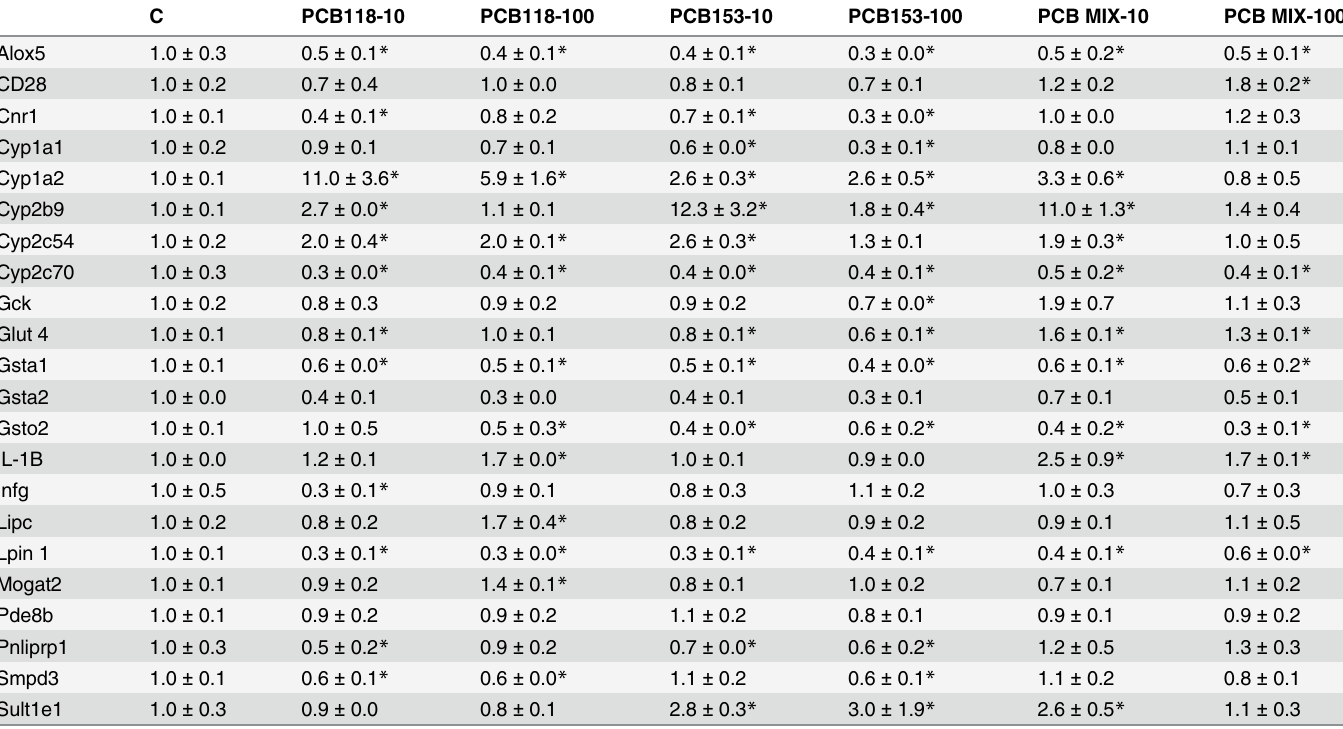
Table 8. Real-time RT-PCR validation of genes selected within the liver after microarray analyses ( * p < 0.05).